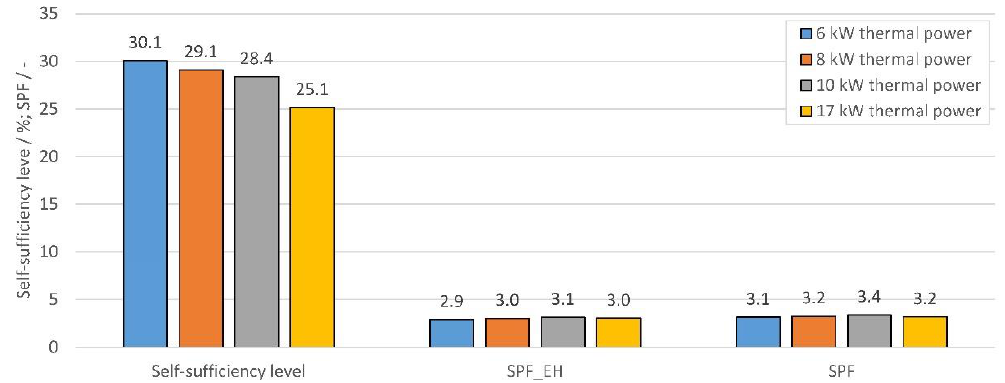
Figure 7. Self-sufficiency level and seasonal performance factors of SFH category 1 reference building for the year 2020 with variation of BWHP size.